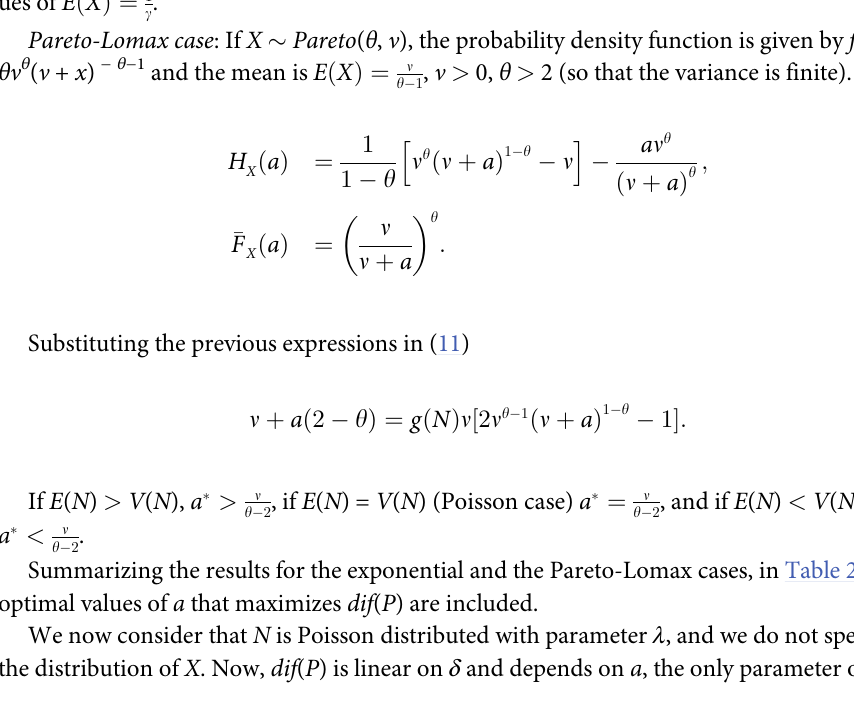
Table 2. Optimal a in absolute deductible in the Poisson-exponential and Poisson-Pareto-Lomax cases. E ( N ) < V ( N